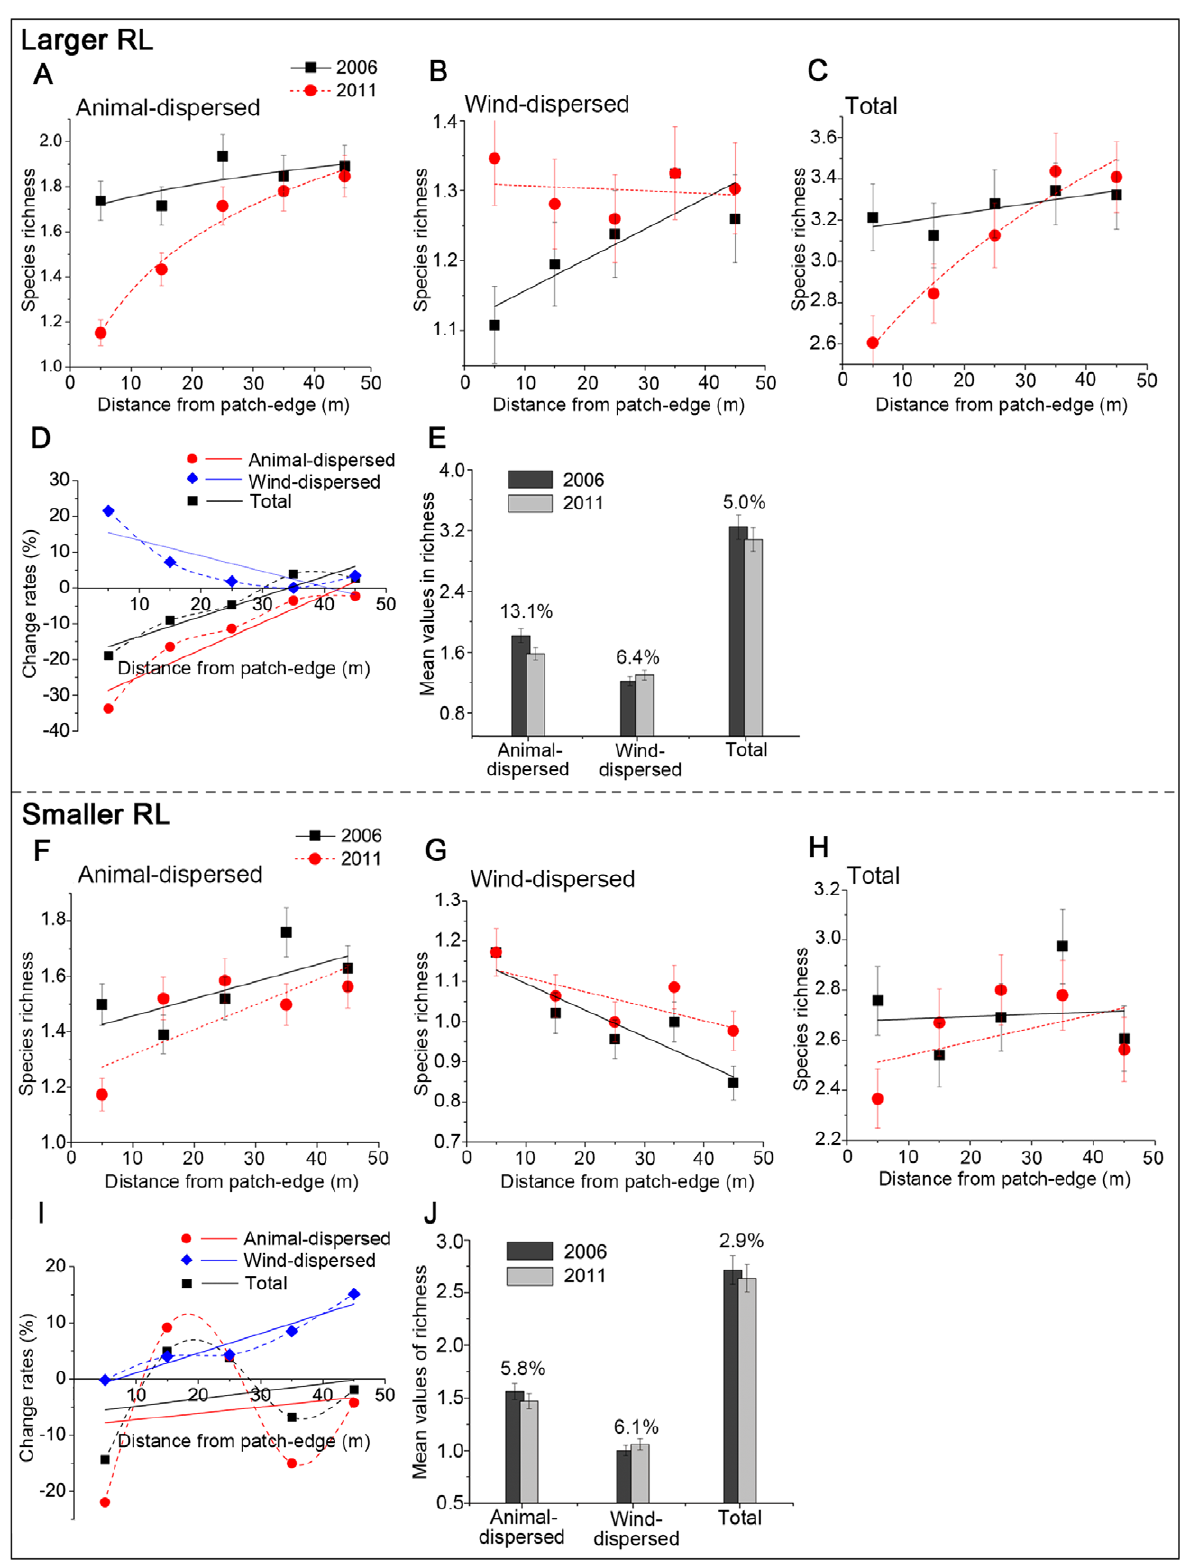
Figure 4. Species richness of animal- and wind-dispersed groups, and total communities. A–C and F–H represent average species richness at each distance in the two landscapes; D and I represent the change rates of each group at each distance; E and J represent overall change of each group in richness across distances from patch-edge.